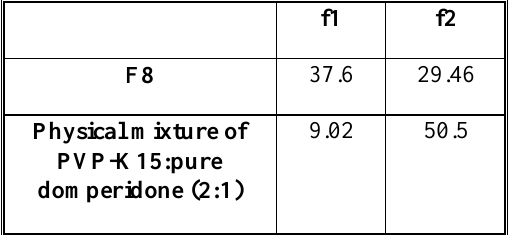
Physical mixture of